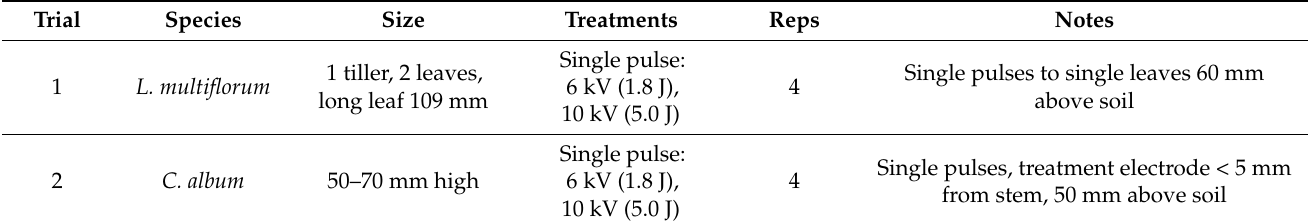
Table 1. Trial summary table showing trial number, weed species, plant size, single electric pulse treatments applied and number of replicates.